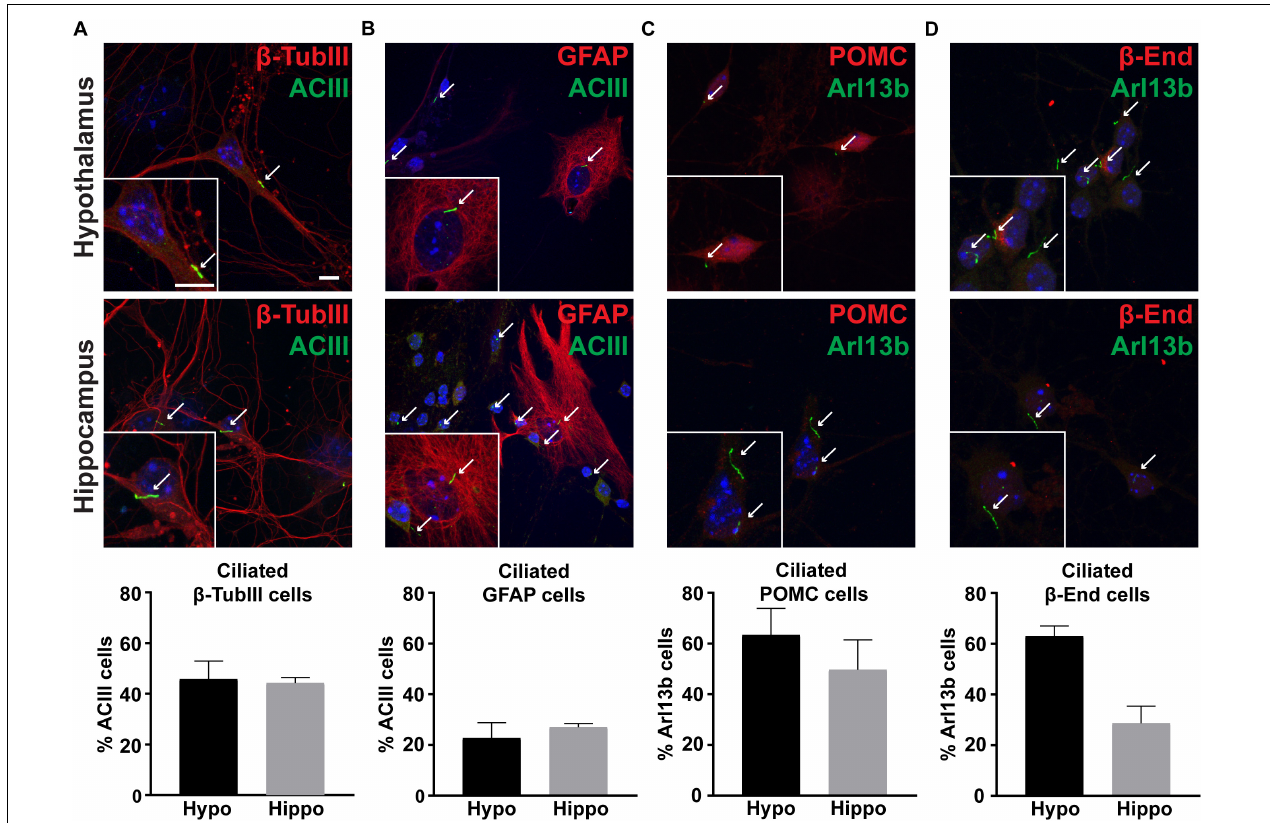
FIGURE 4 | Cultures possess primary cilia. (A) β -tubulin III ( β -TubIII, red) stained neurons with adenylyl cyclase III (ACIII, green) positive cilia. (B) Glial fibrillary acidic protein (GFAP, red) stained astrocytes with adenylyl cyclase III (ACIII, green) positive cilia. (C) Proopiomelanocortin (POMC, red) expressing, and (D) β -endorphin ( β -End, red) expressing neurons with ADP Ribosylation Factor Like GTPase 13B (Arl13b, green) positive cilia in both hypothalamic and hippocampal derived neurons. Hoechst stained nuclei are blue. Arrows indicate cilia. Scale bars are 10 µ m. Percentage of cilia marker positive cells divided by the total number of associated cell type assessed per hypothalamus or hippocampus is graphed as mean ± SEM. Data collected from 3 hypothalamic and hippocampal samples from 3 experimental days. β -tubulin III cells with ACIII positive cilia/total hypothalamic β -tubulin III positive cells: 152/336, β -tubulin III cells with ACIII positive cilia/total hippocampal β -tubulin III positive cells: 160/323, GFAP cells with ACIII positive cilia/total hypothalamic GFAP positive cells: 32/126, GFAP cells with ACIII positive cilia/total hippocampal GFAP positive cells: 42/108, POMC cells with Arl13b positive cilia/total hypothalamic POMC positive cells: 100/166, POMC cells with Arl13b positive cilia/total hippocampal POMC positive cells: 28/57, β -endorphin cells with Arl13b positive cilia/total hypothalamic β -endorphin positive cells: 124/203, and β -endorphin cells with Arl13b positive cilia/total hippocampal β -endorphin positive cells: